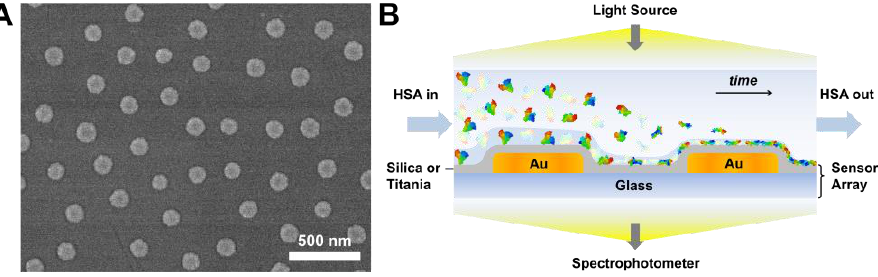
Figure 1. ( A ) Representative top-down SEM image of the gold nanodisk sensor array; and ( B ) a schematic illustration of HSA adsorption onto silica- and titania-coated gold nanodisk arrays.